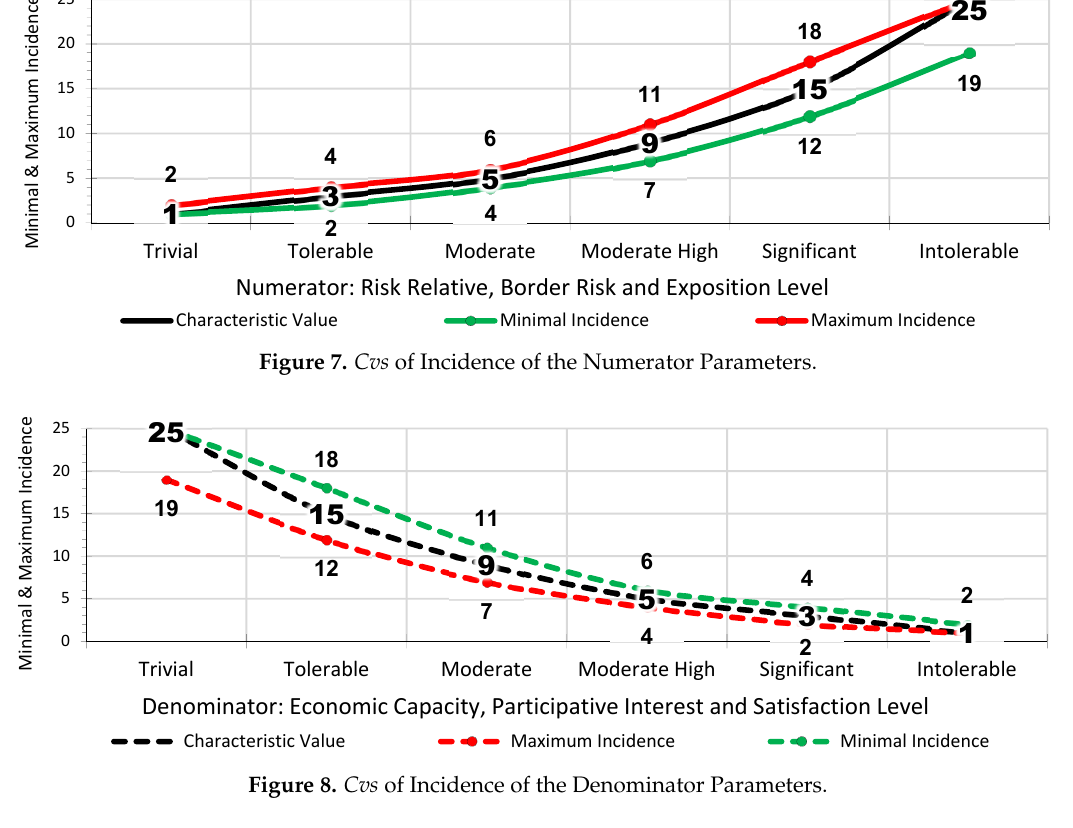
Table 8. Incidence of Cv on risk.